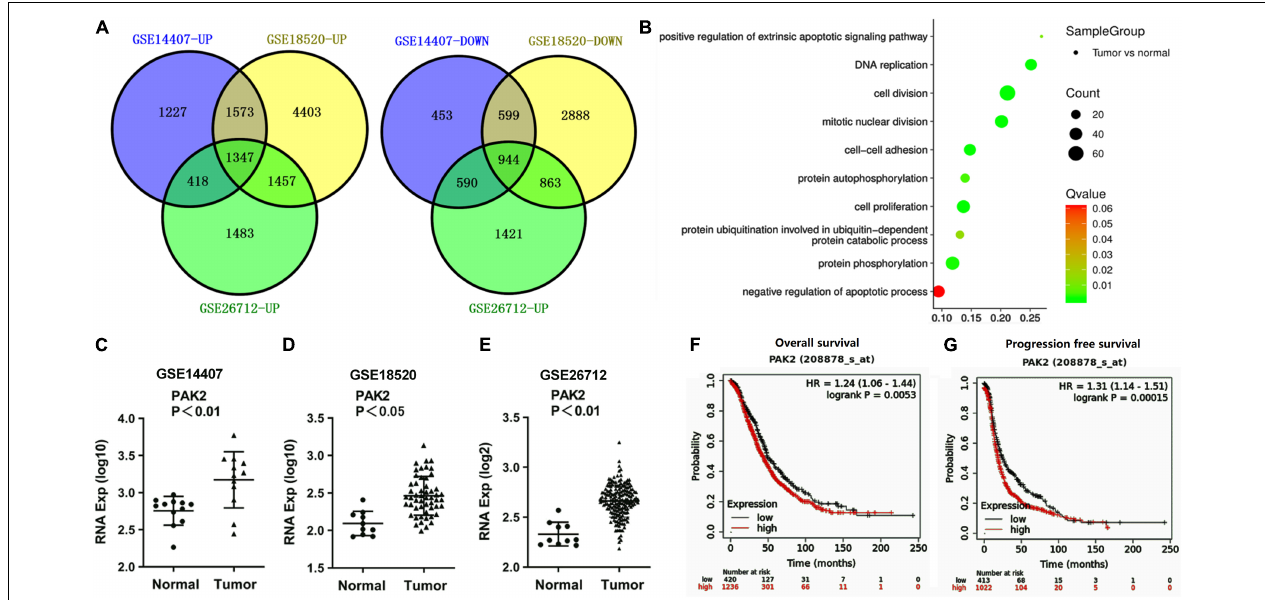
FIGURE 2 | PAK2 was predicted to be an oncogene of OC. (A) Venn diagram analysis respectively identified 1,347 upregulated and 944 downregulated differentially expressed mRNAs. (B) The top 10 pathways obtained by GO term analysis. (C–E) PAK2 expression was distinctly upregulated in OC tissues. (F,G) High expression of PAK2 was closely associated with poor prognosis of OC patients. OC, ovarian cancer; GO, Gene Ontology; PAK2, P21 (RAC1) Activated Kinase 2.